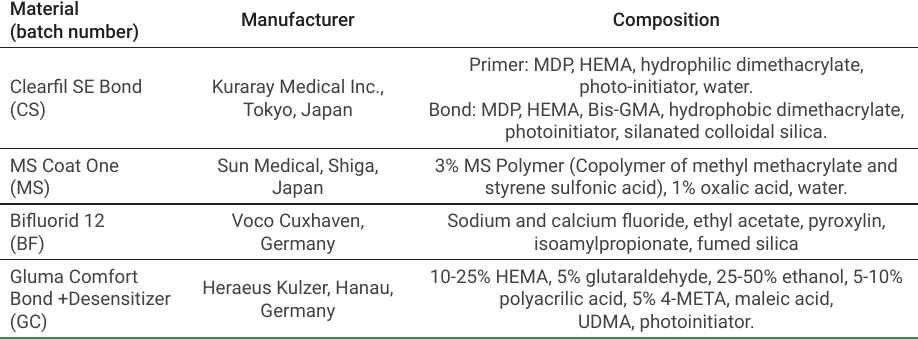
Table 1. Description of the materials used in the study Material (batch